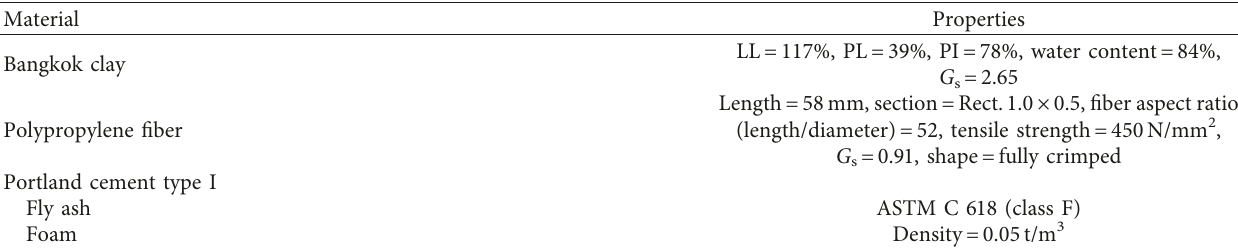
Table 1: Properties of materials.